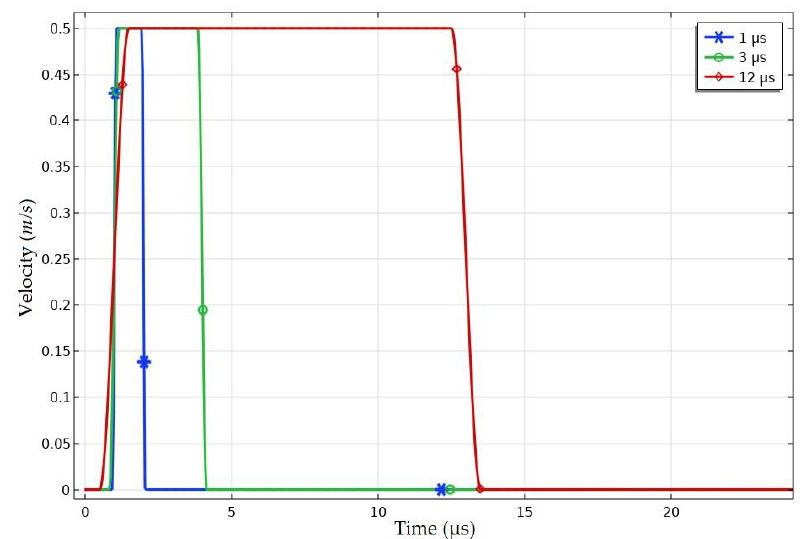
Figure 2. The inlet velocity for inkjet printhead nozzle (determined by waveform functions). Here, the printhead was actuated by an optimized waveform with different dwelling times t 1 = 1 µ s, t 2 = 3 µ s, and t 3 = 12 µ s. The considered droplet ejection times were set